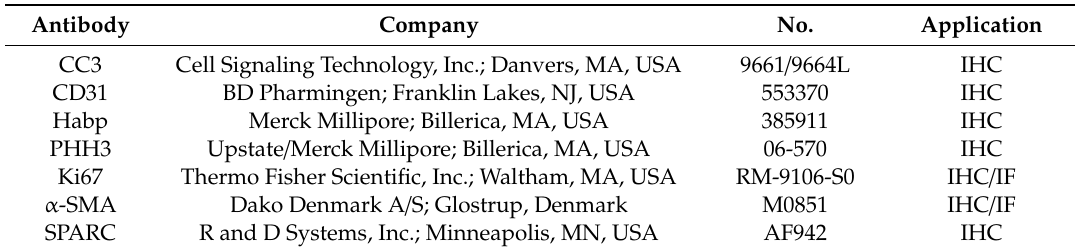
Table 1. Antibodies used for immunohistochemistry (IHC) and immunofluorescence (IF) staining. Abbreviations: α -SMA, α -smooth muscle actin; SPARC, secreted protein acidic and rich in cysteine. Antibody